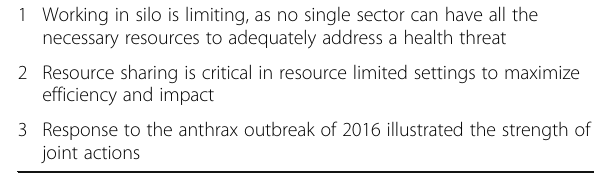
Table 8 The strength of joint action (Umoja ni